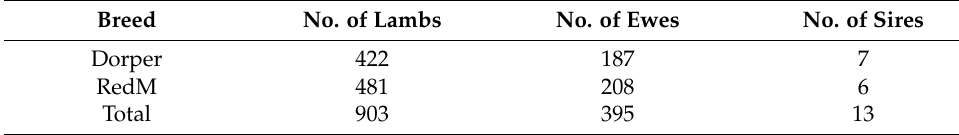
Table 1. Summary of the data analyzed in this study.